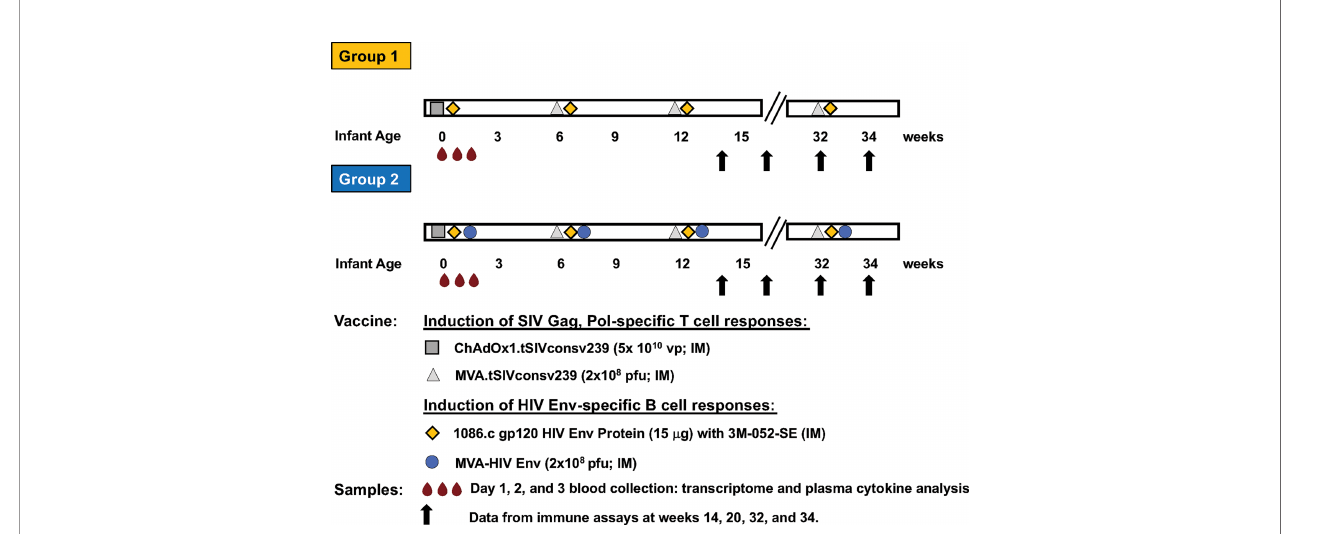
FIGURE 1 | Vaccine study overview. The timeline of immunization with the speci fi c vaccine regimens and timepoints of immunizations for Group 1 and Group 2 are illustrated in horizontal bars. Each vaccine is indicated by a distinct symbol; vaccine dose and route of administration are listed in the legend. Blood samples (red droplets) are the vaccine prime were collected at days 0 (immediately prior to immunization) and at days 1 and 3 post prime. Vaccine-induced adaptive immune responses were measured at weeks 14, 20, 32 and 34, with results having been reported previously (15,